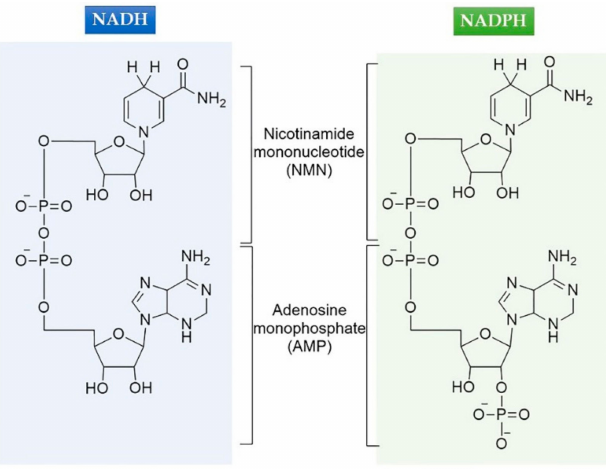
Figure 1. Chemical structures of NADH and